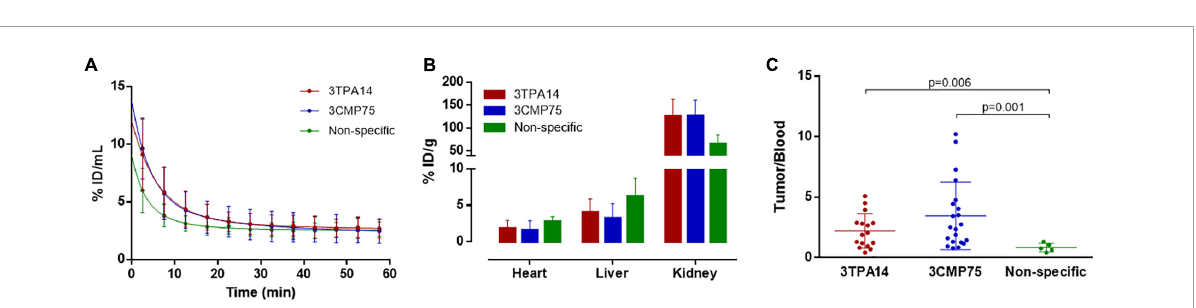
FIGURE5 Biodistribution and pharmacokinetics of [ 68 Ga]Ga-NOTA-Nanobodies. (A) Curves obtained from dynamic PET images representing the blood (heart left ventricle) concentration-time profiles from animals injected with [ 68 Ga]Ga-NOTA-3TPA14 (red line), [ 68 Ga]Ga-NOTA-3CMP75 (blue line), and [ 68 Ga]Ga-NOTA-Non-specific (green line). (B) Biodistribution (%ID/g) of the radiotracers [ 68 Ga]Ga-NOTA-3TPA14 (red bars), [ 68 Ga]Ga-NOTA-3CMP75 (blue bars), and [ 68 Ga]Ga-NOTA-Non-specific (green bars) in heart, liver, and kidneys. (C) Uptake levels of [ 68 Ga]Ga-NOTA-3TPA14 (red dots), [ 68 Ga]Ga-NOTA-3CMP75 (blue dots), and [ 68 Ga]Ga-NOTA-Non-specific (green dots) in MDA-MB-231-tumors expressed as maximum tumor-to-blood ratios from static PET images at 45 min after iv injection of radiotracers. P -values are indicated. All data are represented as mean ±